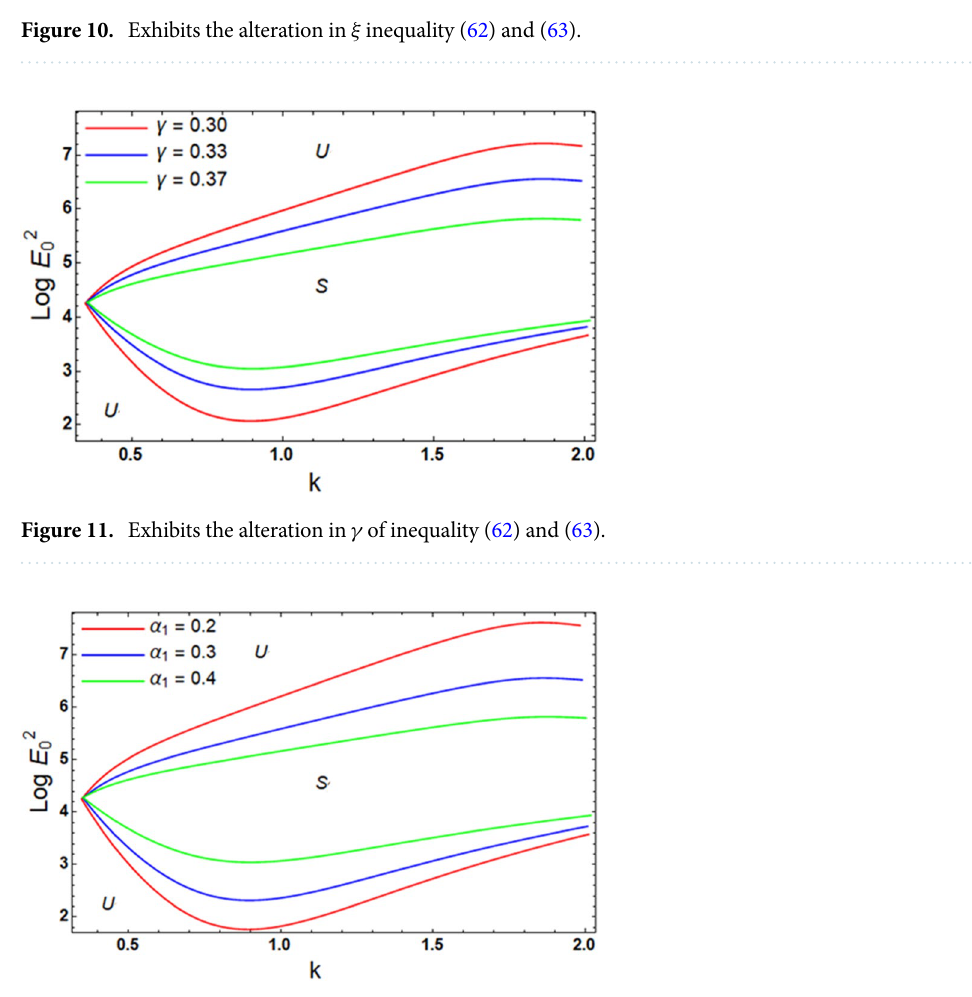
Figure 12. Exhibits the alteration in α 1 of inequality (62) and